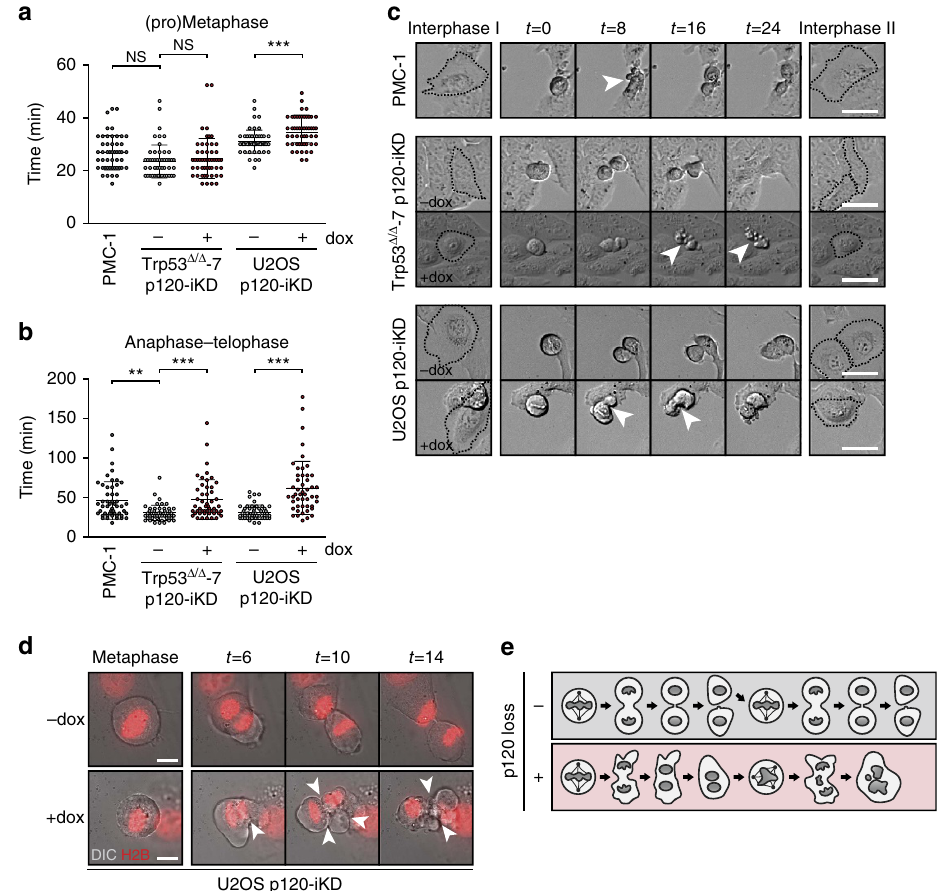
Figure 3 | Loss of p120 induces cytokinesis defects. ( a , b ) Quantifications of the length of ( a ) early mitosis (pro-metaphase and metaphase) and ( b ) late mitosis/cytokinesis (anaphase and telophase) in PMC-1, control and dox-treated Trp53 D / D -7 p120-iKD and U2OS p120-iKD cell lines. Statistical significance was determined using the Student’s t -test. * P o 0.05, ** P o 0.01, *** P o 0.001. ( c ) Time-lapse imaging of PMC-1, and control and dox-treated Trp53 D / D -7 p120-iKD and U2OS p120-iKD cells. Shown are 10X DIC images. Scale bar, 25 m m. ( d ) High-magnification time-lapse imaging of H2B-mCherry expressing control and dox-treated U2OS p120-iKD. Shown are (cid:3) 100 images. Arrowheads depict severe membrane deformation in dox-treated anaphase cells leading to cytokinesis failure. Scale bar, 10 m m. ( e ) Loss of p120 induces binucleation through cytokinesis defects during anaphase. During subsequent cell divisions, this can give rise to chromosomal instability and aneuploidy in cancer cells due to the presence of extra